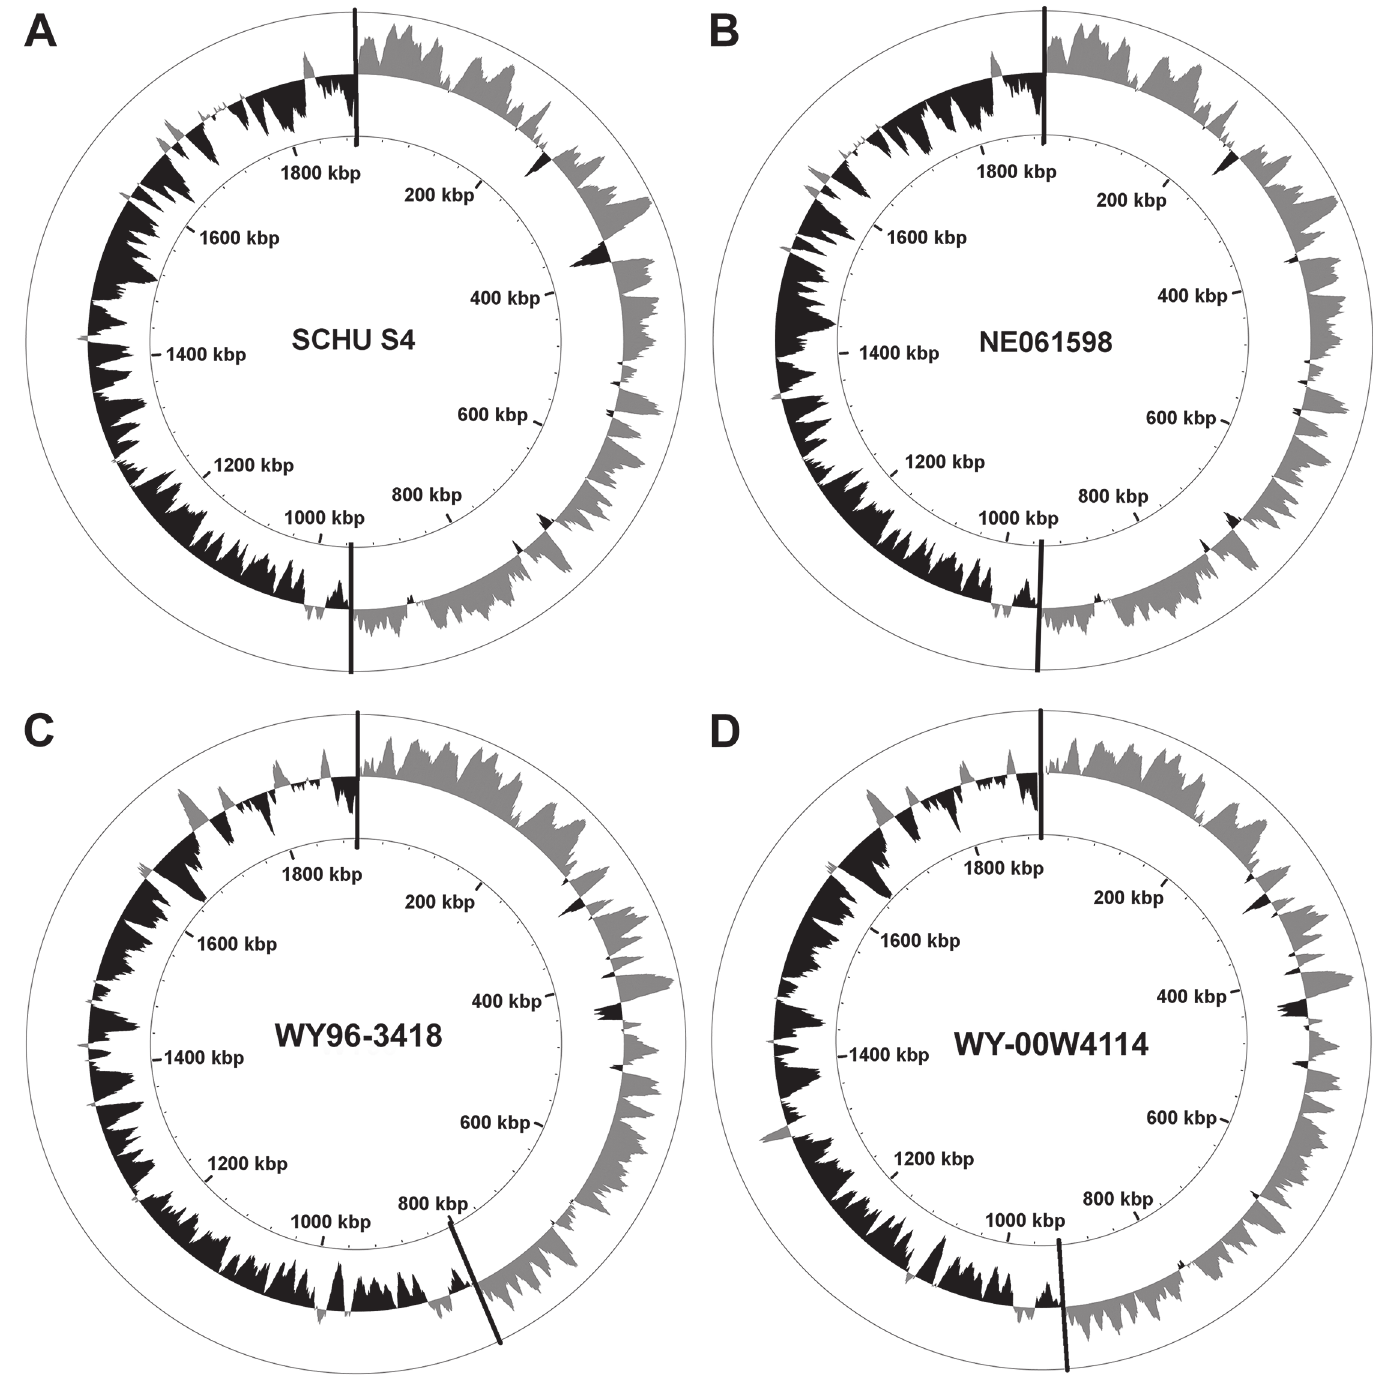
Fig 3. Diagram illustrating GC skew within chromosomal topology map for F . tularensis A.I and A.II strains. The circular F . tularensis chromosome of subtype A.I strains are represented by SCHU S4 (A) and NE061598 (B), and WY96-3418 (C) and WY-00W4114 (D) represent the subtype A.II strains. The origin ( ori ) and termination ( ter ) region are denoted by a vertical black line at the top and bottom, respectively, of the corresponding chromosomal map. GC skew + (gray) and GC skew — (black) is shown in the outermost circle for each genome and the kilobase pair position is indicated in the innermost circle.